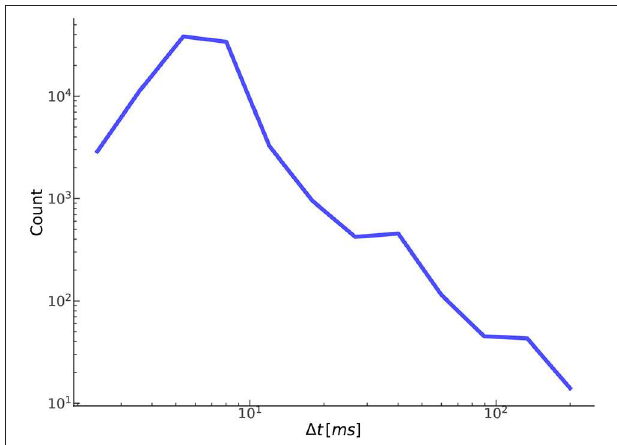
FIGURE 9 | Shown here is the relationship between the number of true positives and their temporal offset error.